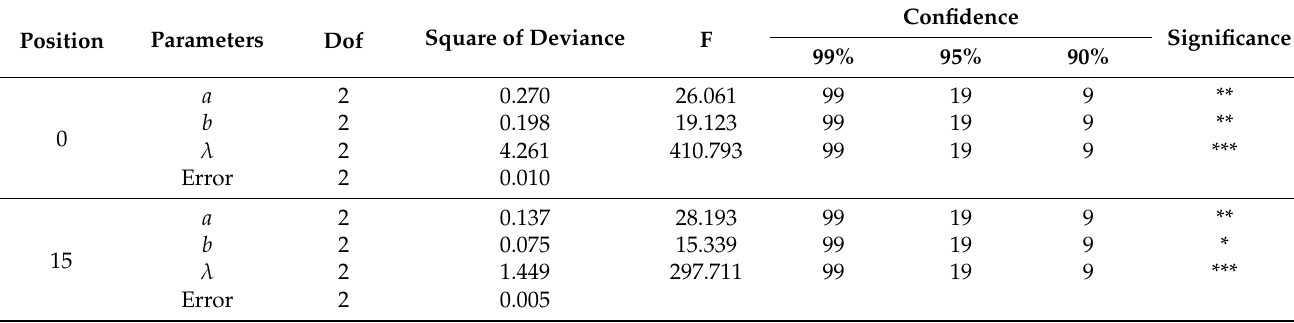
Table 5. Variance analysis of influence factors of radial displacement.